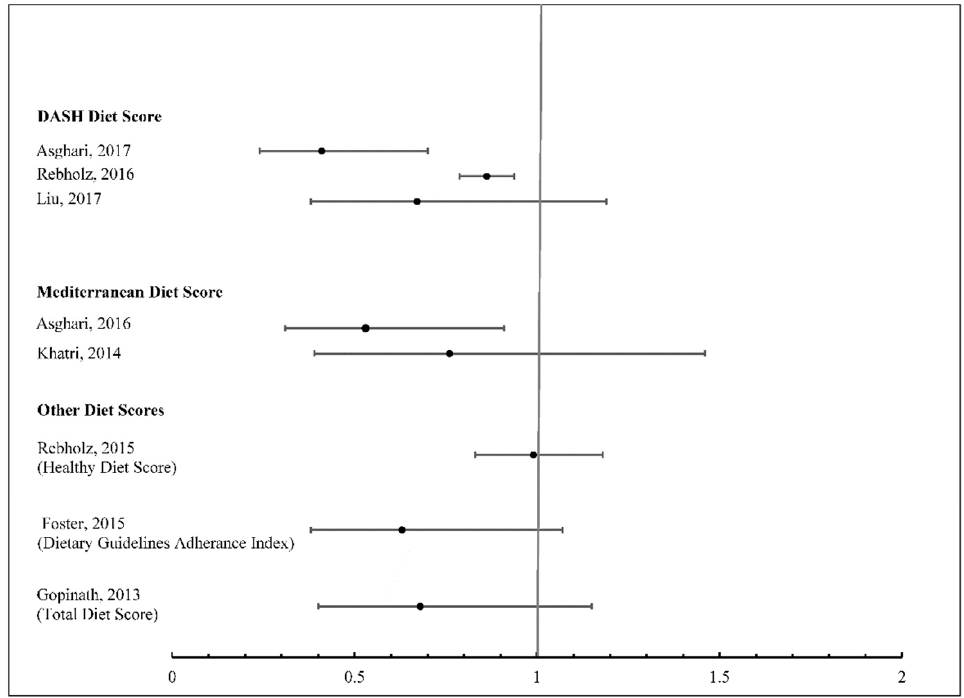
Figure 2. A priori dietary patterns and risk of chronic kidney disease in prospective studies 1 . 1 The association measures compared the highest and lowest categories of diet scores with the lowest category of the diet score as the reference.